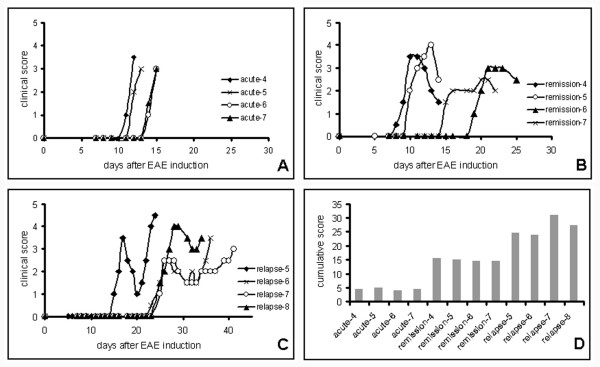
Summary of the clinical courses and cumulative scores of the DA rats chosen for the RealTime-PCR experiments. A) acute phase, B) recovery phase, C) relapsing phase, D) cumulative disease scores (area under the curve) of the examined animals.